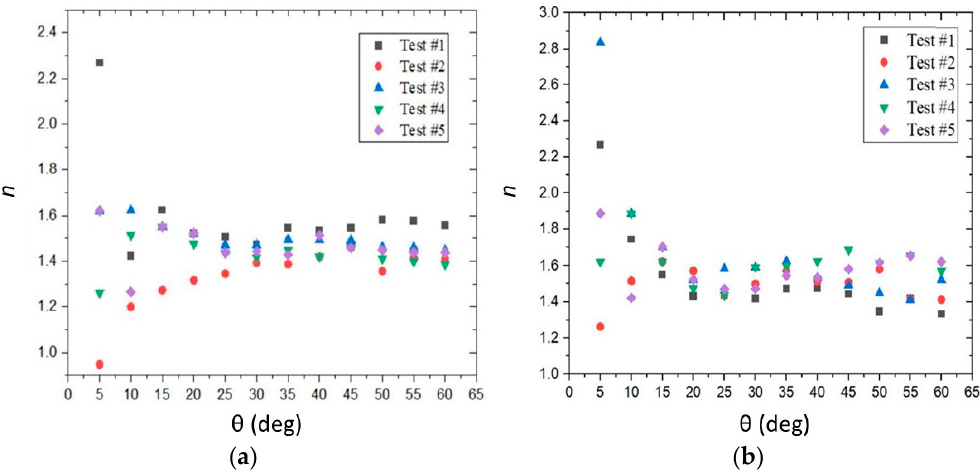
Figure 4. Refractive index, n , for ( a ) VC and ( b ) SC extracted five times in different places over the material as a function of calculated angle, θ . When the experiment works as it should, the profile is flat over the central angular region, quickly allowing an assessment of quality of measurement with meaningful error arising from its distribution. When the experiment is not well-aligned or the flats are not parallel, the flatness window quickly narrows. Importantly, measuring at 0° reveals how sensitive the measurement is when performing simple orthogonal measurements, providing a reason for significant variation in the literature. It likely arises from accurate differing alignment and beam discernment, including when passing through a splitter.